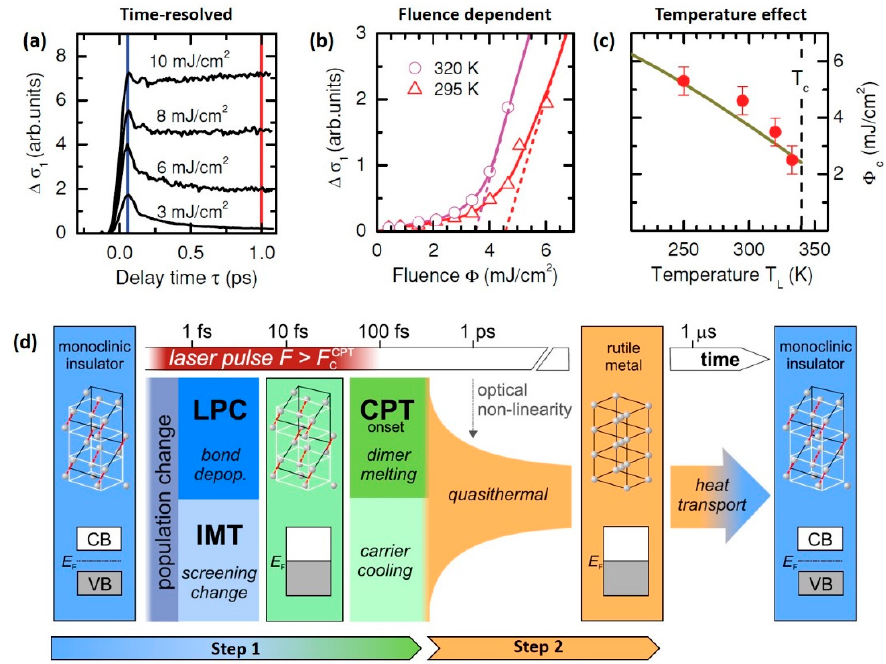
Figure 5. Ultrafast IMT triggered by pulse pump laser. ( a ) THz conductivity change ( ∆ σ 1 ) of poly- crystalline VO 2 film (120 nm-thick, deposited on diamond substrate) after excited by a 12 fs, 800 nm laser pulse at 295 K for different pump fluence. ( b ) Extrapolation of ∆ σ 1 (at 1 ps) curves (red triangles: 295 K, magenta circles: 320 K) to a critical fluence of Φ c (295 K = 4.6 cm 2 and Φ c (320 K) = 3.5 mJ/cm 2 , respectively). ( c ) Dependence of threshold fluence Φ c on lattice temperature T L . Reproduced from [89], with permission from American Physical Society 2011. ( d ) Comprehensive picture of the ultrafast dynamics in VO 2 film during the photoinduced phase transition. Optical excitation uses ~60 fs, 800 nm pump laser pulse above F CPT (fluence threshold for crystallographic phase transition). The main two steps: (1) Characterized by metastable metallic state with mono- clinic lattice structure. Initially, the screening of the coulomb interaction (CIA) is disturbed, leading to the IMT on screening timescales (few fs). On the same timescale, V–V bonding orbitals are de- populated by photoexcitation [51], leading to the lattice potential change (LPC) [50]. The resulting transient phase of vanadium dioxide in this stage is a highly excited metal with monoclinic atom arrangement. The crystallographic phase transition (CPT) subsequently happens characterized by the melting of the V-dimers [53], concurrently with the relaxation of excited electrons and holes (carrier cooling) in the metallic band structure [51]. (2) Then, the system evolves quasi-thermally to its high-temperature equilibrium rutile metallic phase in ~300 ps, marking the completion of IMT. The photoinduced rutile metal phase maintains until sufficient heat has been transported away, on a timescale varying from several microseconds to hundreds of microseconds depending on the local thermal diffusivity. Reproduced from [55], with permission from Elsevier